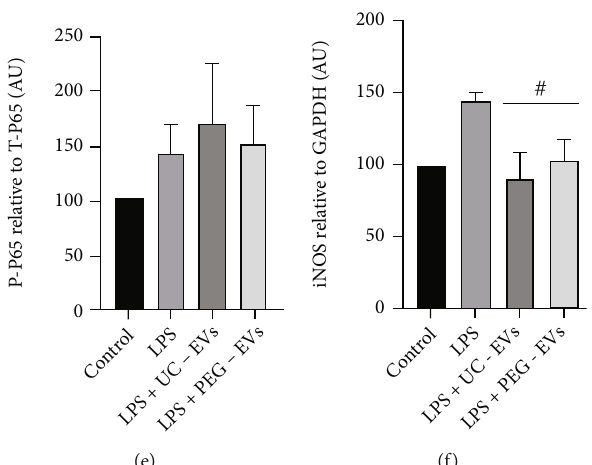
Figure 5: EV treatment leads to changes in the protein expression of THP-1 cells with LPS induction. (a) The in situ CD11b and CD163 expression of THP-1 cells was analyzed by immuno fl uorescence staining, scalebar = 50 μ m . There were strong positive cells (white arrow), medium positive cells (yellow arrow), and negative cells (red arrow) in each group. The statistical analysis of MFI (mean fl uorescence intensity) indicated that there were no signi fi cant di ff erences in (b) CD11b and (c) CD163 in the groups. (d) Western blotting was used to determine the protein levels of phospho-P65, total-p65, and iNOS, and GAPDH was used as a control. The statistical analysis of protein levels indicated that iNOS relative to GAPDH was signi fi cantly decreased by EV treatment (# compared with the LPS group and P < 0 : 05 ), but there were no signi fi cant di ff erences in (e) P-P65 relative to T-P65 and (f) iNOS relative to GAPDH in comparison to UC-EVs and